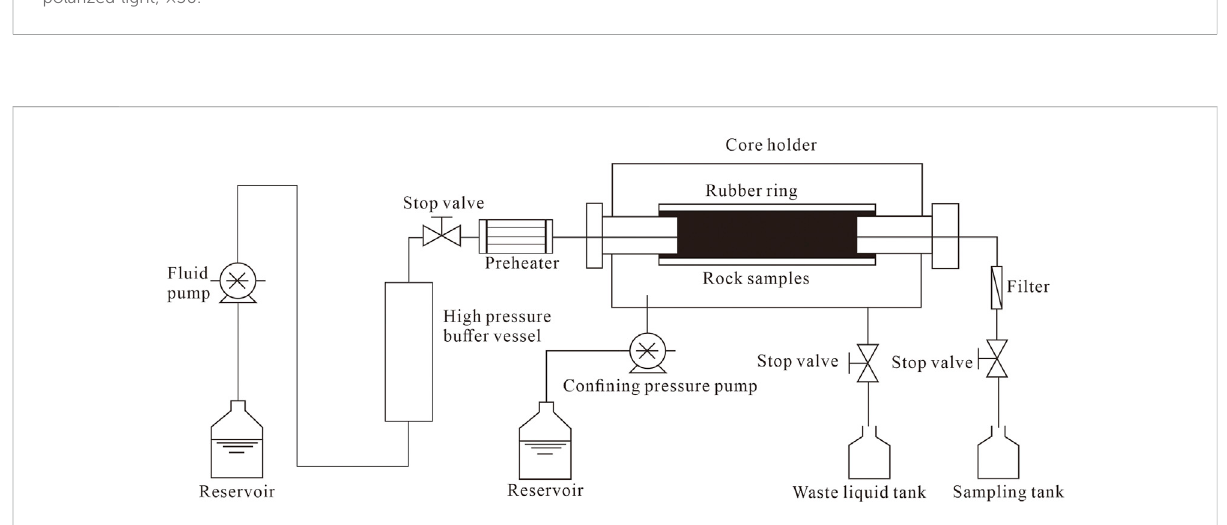
FIGURE 3 Sketch map of continuous fl ow diagenetic simulation